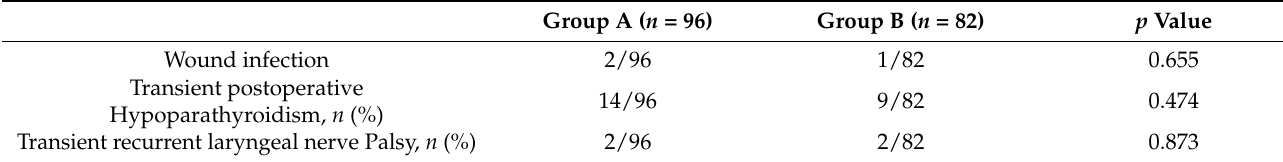
Table 5. Most important complications during